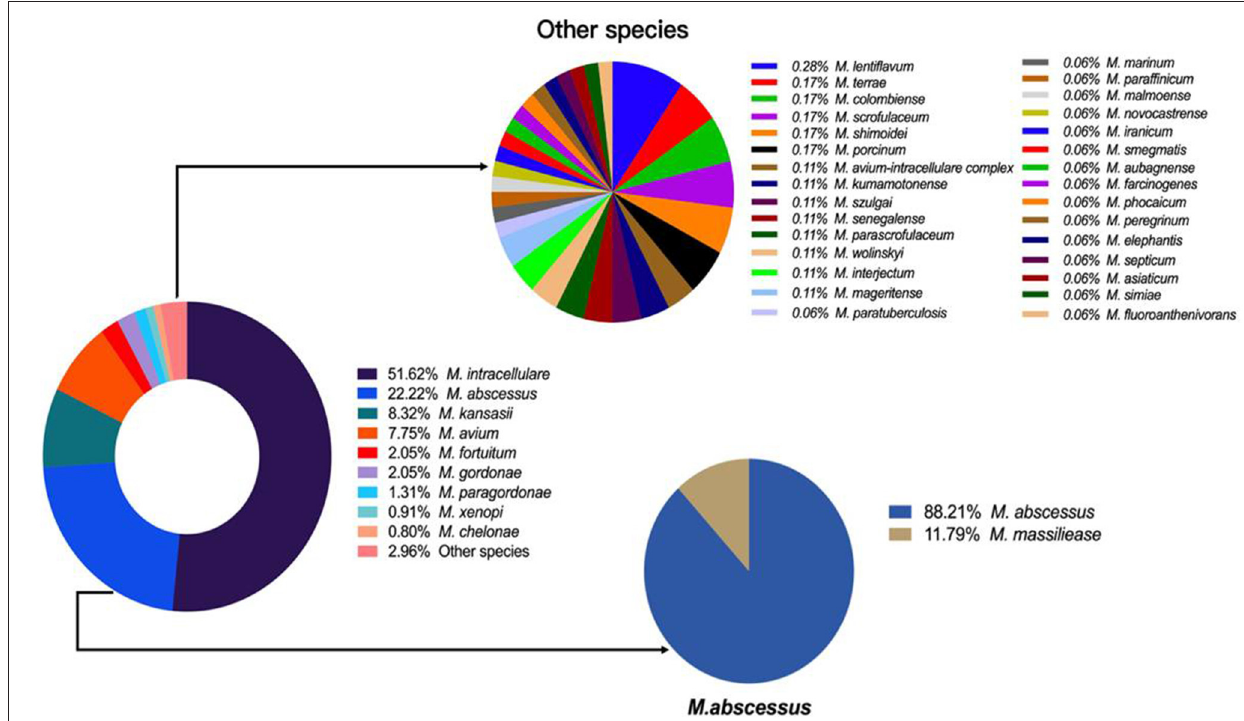
FIGURE 2 | The spectrum of NTM species isolated during 2014–2021.